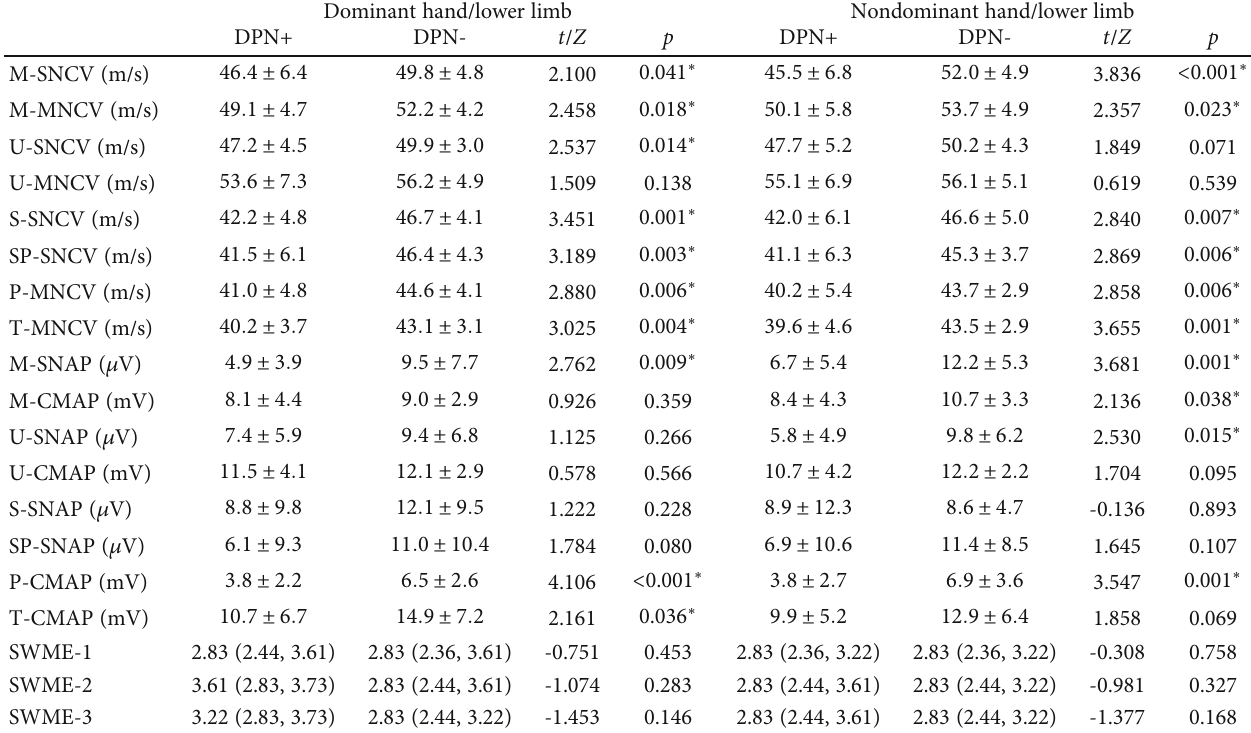
Table 2: Comparison of nerve conduction studies and Semmes Weinstein mono fi lament examination threshold between the two groups. Dominant hand/lower limb Nondominant hand/lower limb